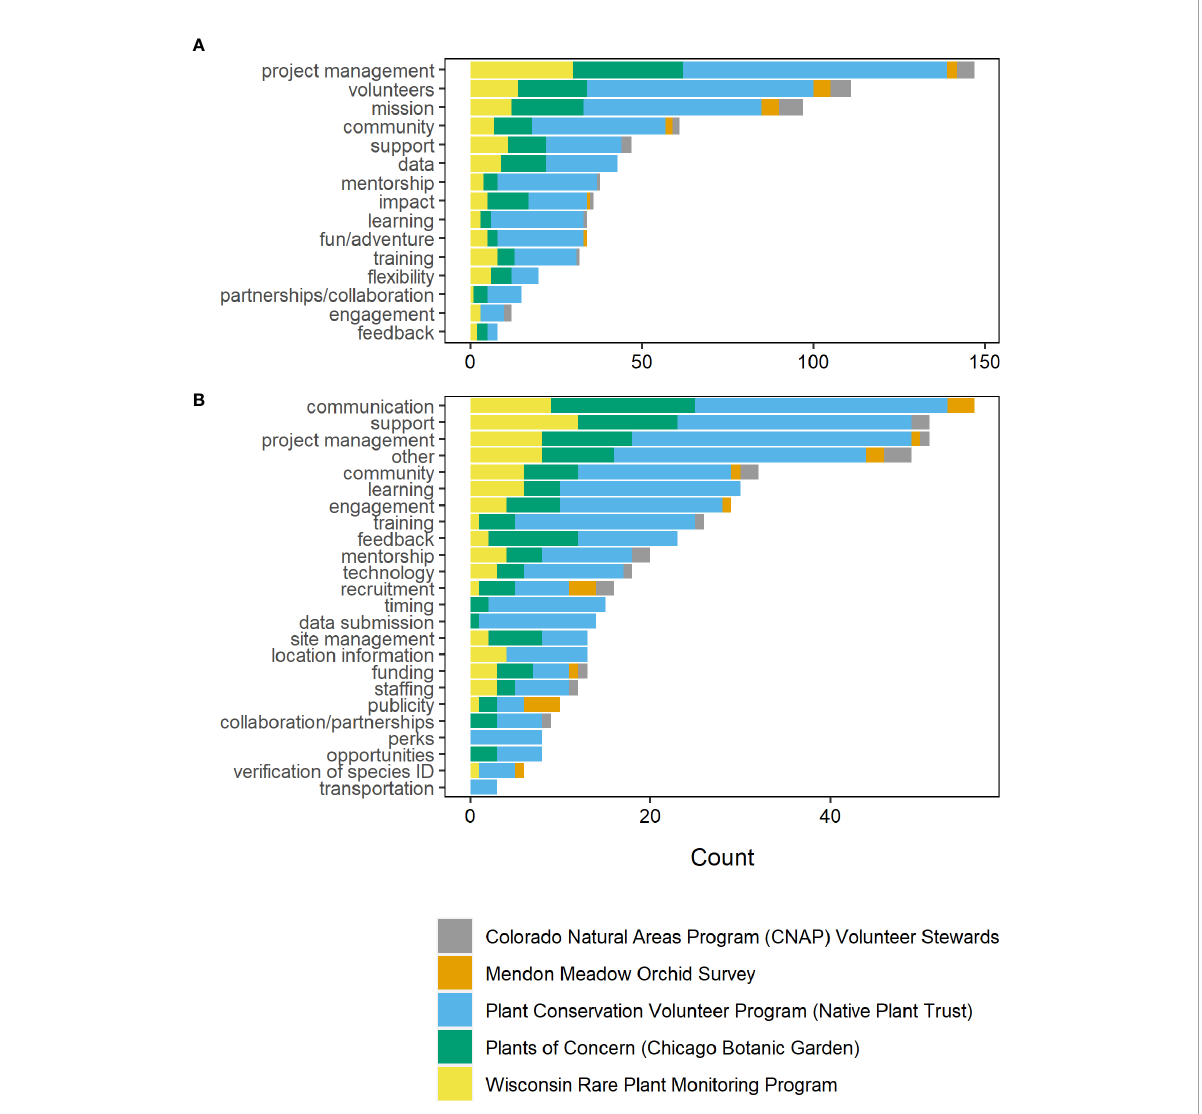
FIGURE 8 (A) Attributes of project success identi fi ed by participants (n = 735). (B) Areas in which projects could be improved as identi fi ed by participants. Examples of "other" suggestions for improvement include connecting people to reduce solo fi eld work, aiding scheduling among survey team members, and widespread photo